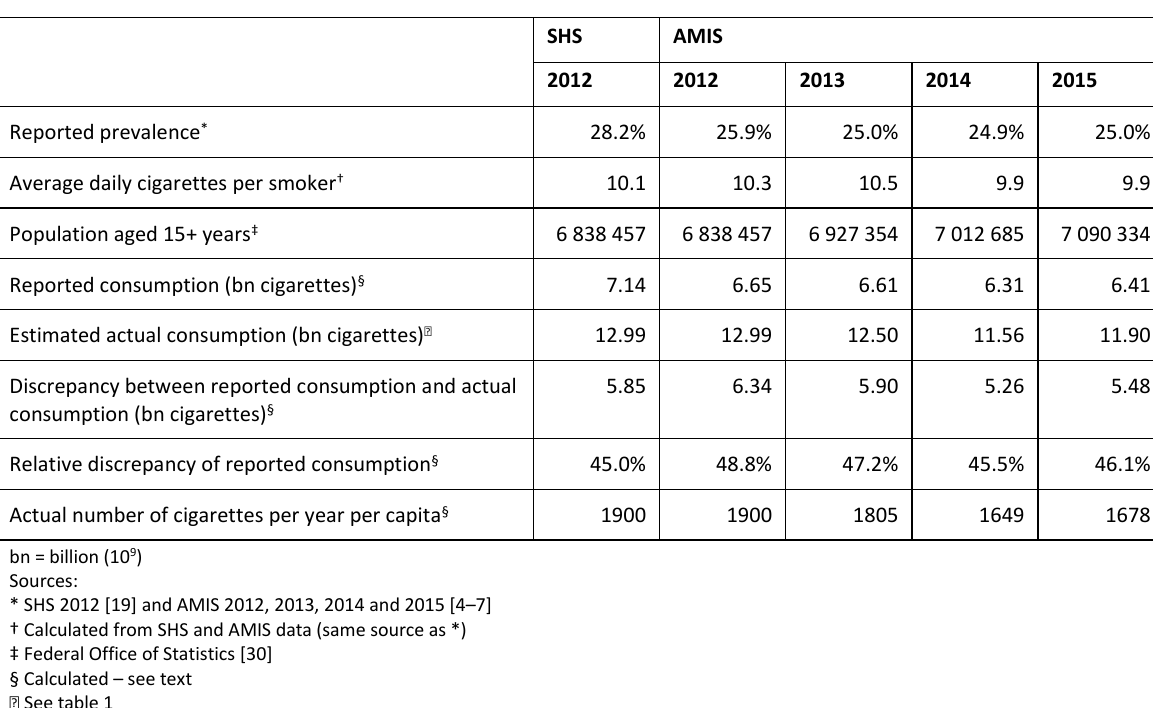
Table 2: Swiss Health Survey (SHS) and Addiction Monitoring in Switzerland (AMIS) reported cigarette consumption com- pared with estimated actual consumption for the years 2012 to